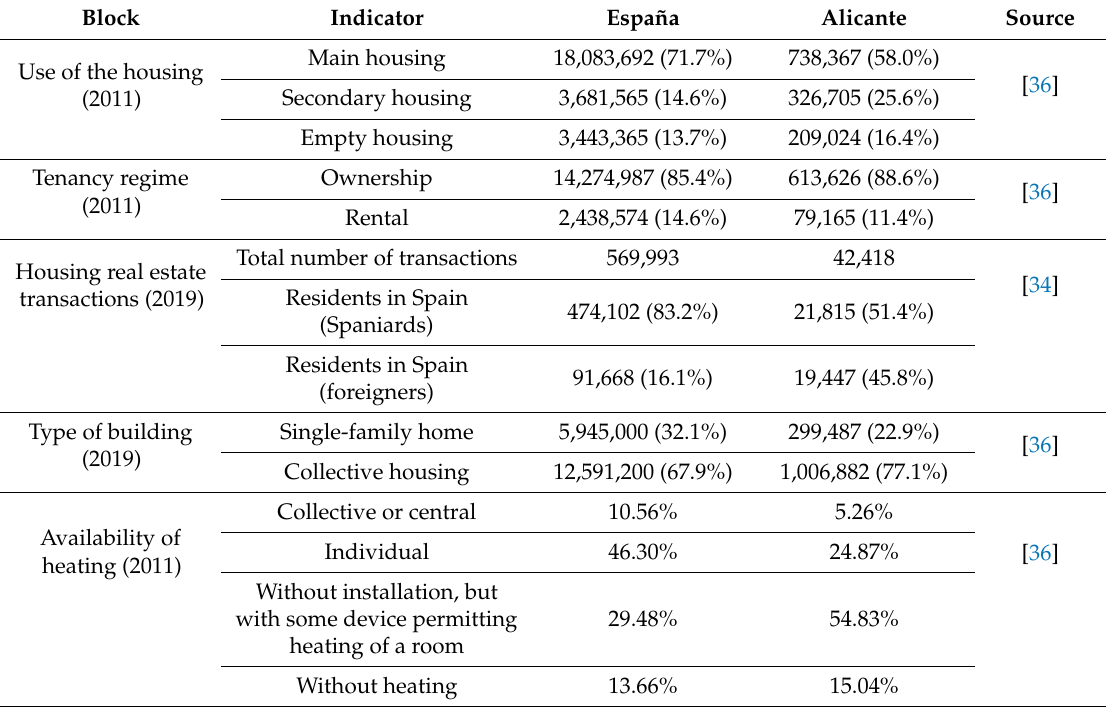
Table A1. Principales indicadores del sector inmobiliario para España y la provincia de Alicante.